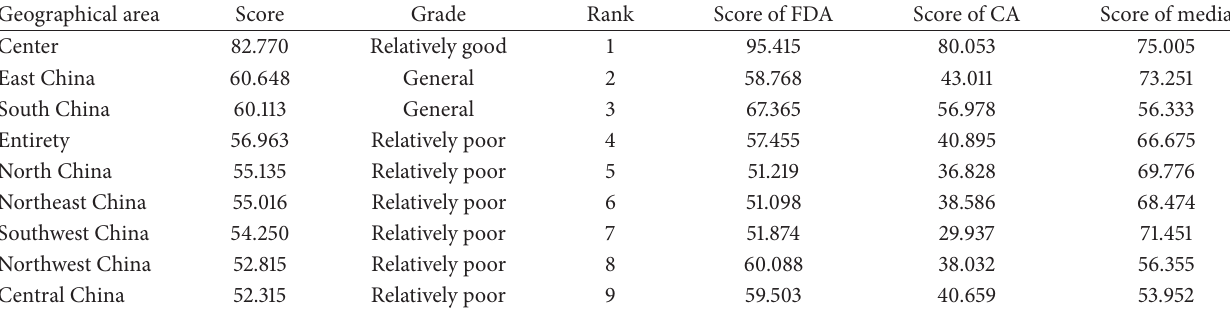
Table 10: Scores of different geographical regions.